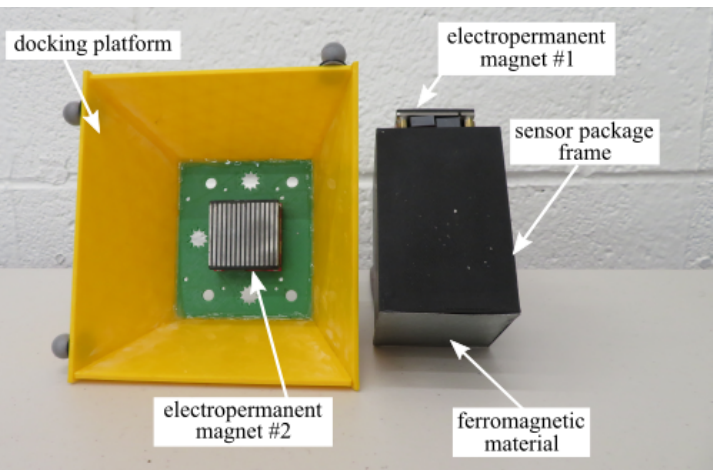
Figure 4. The docking and retrieval system of the sensor package featuring two electropermanent magnets: #1 on the top of the package, used to mount it to the underside of structures; and #2 on the drone docking platform, used to secure, transfer, deliver, and retrieve the